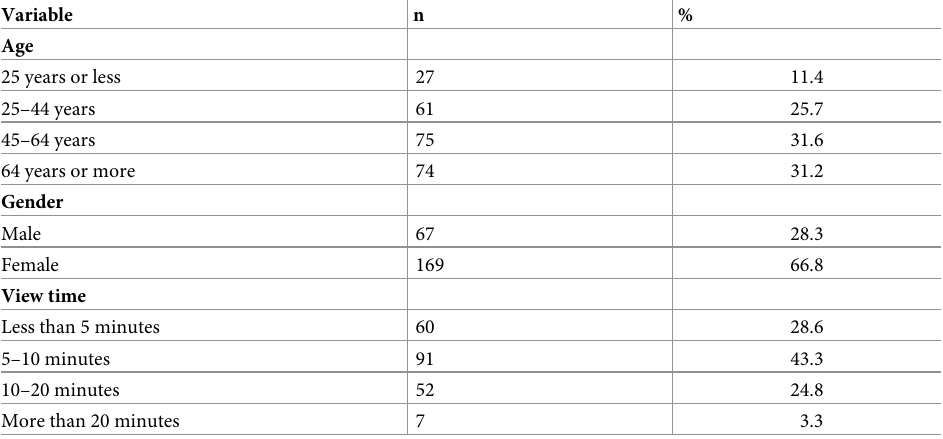
Table 1. Participant demographics (n = 253) at T1 & T2.